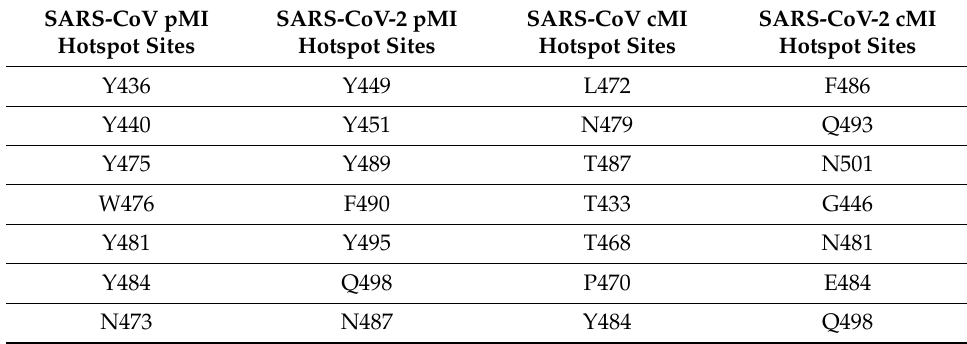
Figure 5. Coevolutionary profiles of the SARS CoV and ACE2 proteins. ( A ) The structure-based pMI profile for SARS-CoV-RBD spike protein is projected onto the SARS-CoV-RBD complex with ACE2 (residue numbering as in pdb id 2AJF). The binding interface residues that make contacts with ACE2 are highlighted in orange filled diamonds. The position of the binding interface residues that di ff er between SARS-CoV-RBD and SARS-CoV-2-RBD are shown in smaller magenta filled circles. ( B ) The pMI profile for ACE2 residues (pdb id 2AJF). The annotation of the binding interface residues is as in panel A. ( C ) The sequence-based cMI profile for SARS-CoV-RBD is projected onto the SARS-CoV-RBD complex with ACE2 (pdb id 2AJF). ( D ) The cMI profile for ACE2 residues (residue numbering corresponds to ACE2 structure in the complex with SARS-CoV (pdb id 2AJF). The annotation of the binding interface residues is as in panel A. The horizontal lines on the graphs are materialized in cyan to indicate thresholds used to di ff erentiate moderate and high values of pMI and cMI scores. Table 2. The pMI and cMI hotspot residues for SARS-CoV-RBD and SARS-CoV-2 RBD